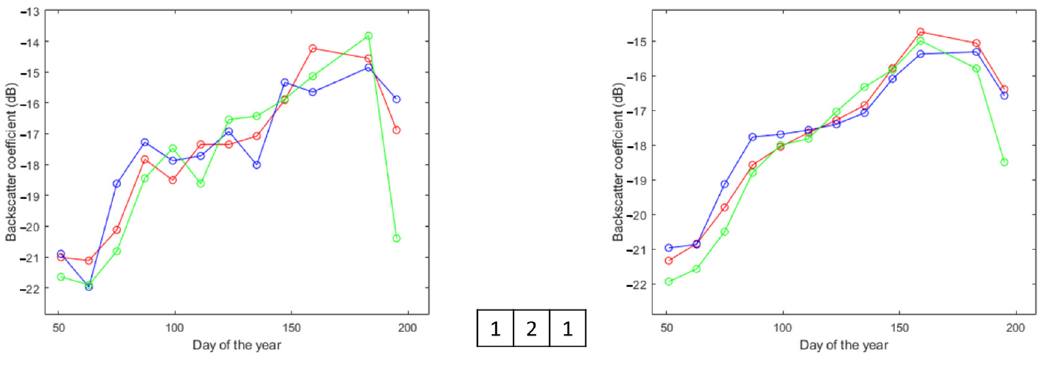
Figure 4. Example of temporal smoothing. ( a ) is the original data, ( b ) is the convolution mask and ( c ) is the data after temporal smoothing. (Each point in Figure 4 is the mean of all pixels within one rice field randomly selected from the study area.).